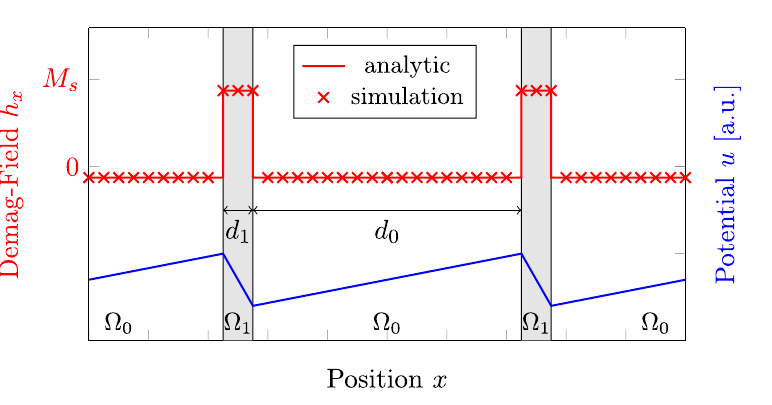
Figure 4. Comparison of the proposed FD method with analytical results for an infinite number of infinitely extended